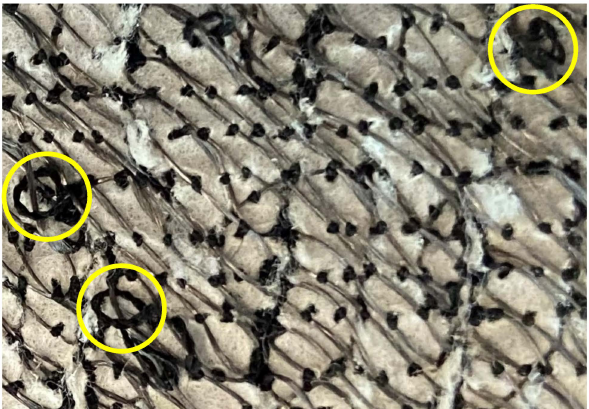
Figure 17. Formation of loops (circled in yellow) underneath the fabric substrate. These loops are produced due to thread tension imbalances that affect the performance of the sensor over a continuous number of stretching